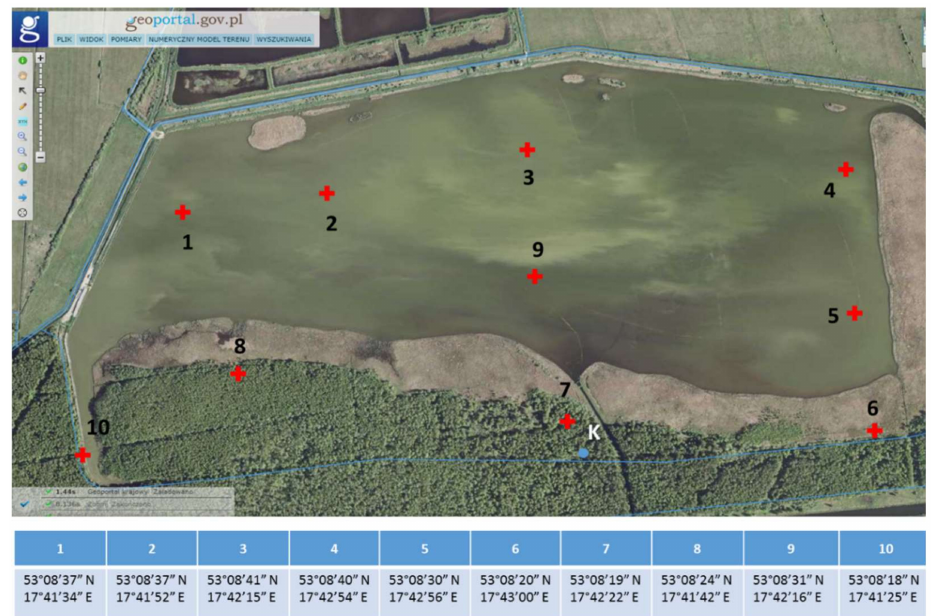
Figure 2. Location of the bottom sediment sampling points on Cardinal